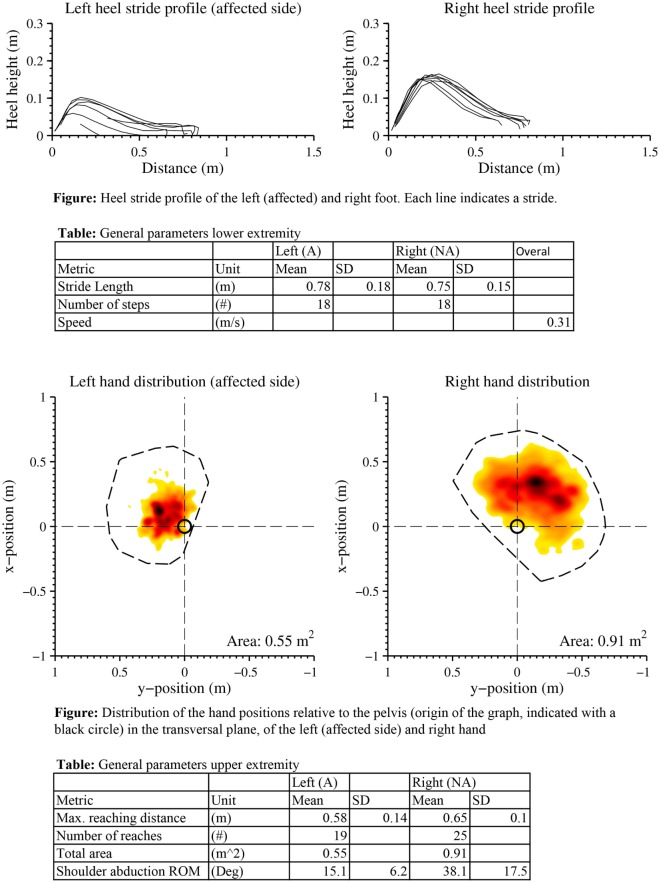
Case report example page 2: a selection of metrics of extremity function from one measurement, as reported in van Meulen et al. (2016).